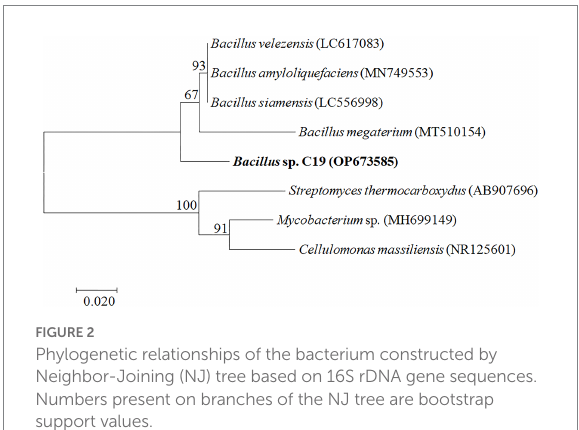
Phylogenetic relationships of the bacterium constructed by Neighbor-Joining (NJ) tree based on 16S rDNA gene sequences. Numbers present on branches of the NJ tree are bootstrap support